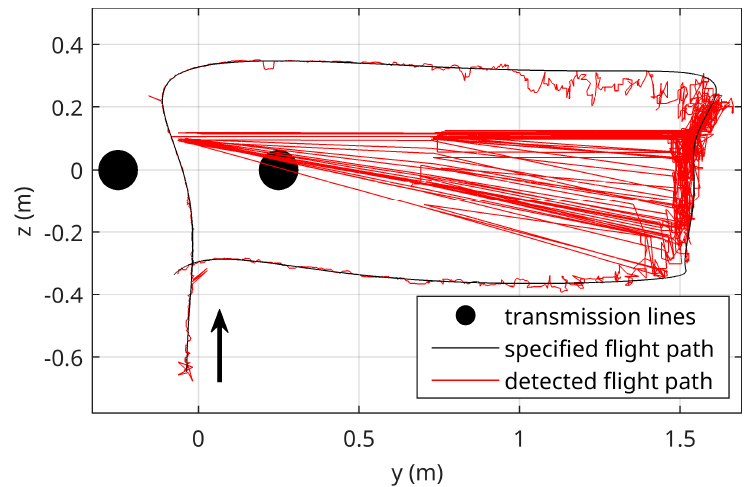
Figure 14. Localization quality close to the transmission lines and far away, three sensors, σ = 8 μ T.